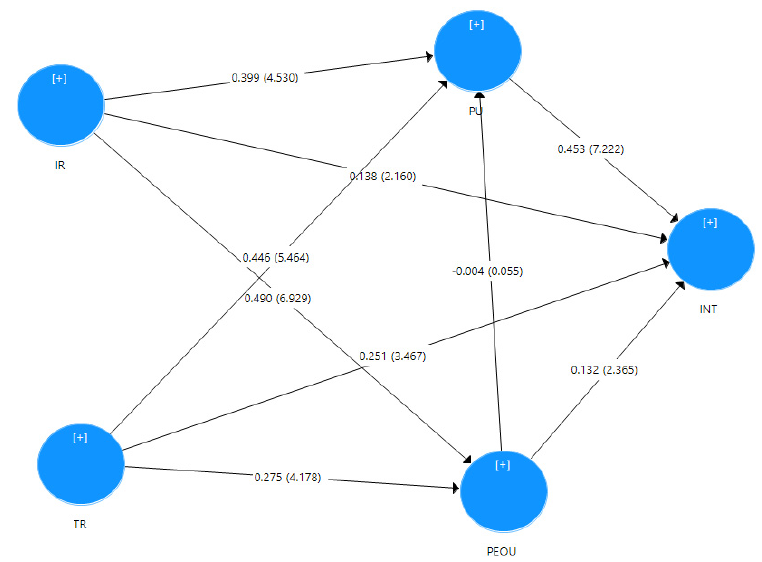
Figure 3. Structural Model. Figure 2. Structural Model.